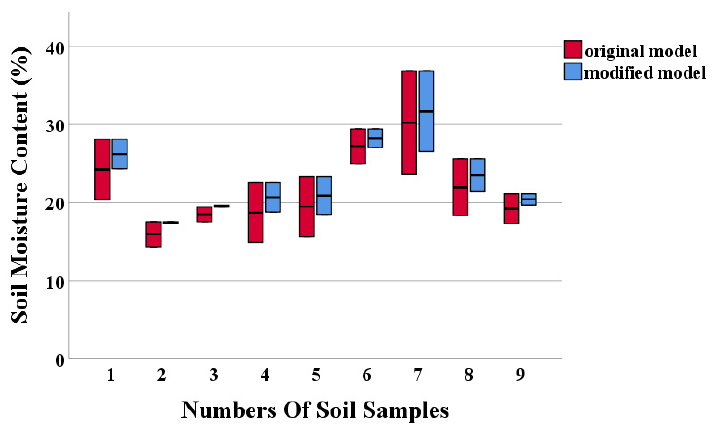
Figure 10. The box plot represented the distance between measured and predicted SMC g using two models.